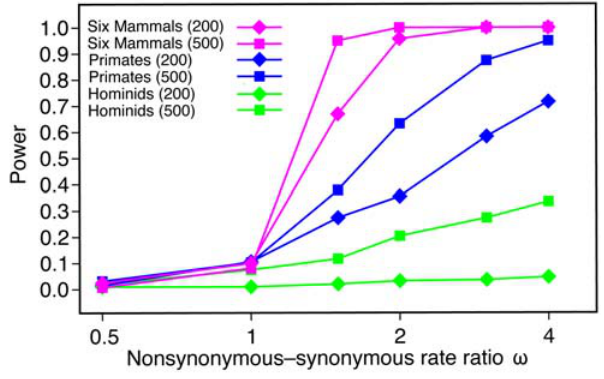
Figure 6. Power of the LRT for selection on any branch of the phylogeny as a function of the nonsynonymous-synonymous rate ratio v . Power is defined as the fraction of tests resulting in nominal P , 0.05. (The effect of controlling for multiple comparisons is shown in Figure S3.) When v # 1, these fractions are estimates of the false positive rate. Each data point is based on 1000 data sets simulated with evolver [84] under the assumption of a constant v among lineages and among sites (model M0). All other parameters (including the transition-transversion ratio k , the codon frequencies, and the branch lengths) were fixed at values estimated from the real data. Results are shown for short (200-codon) and long (500-codon) genes and three sets of species: hominids (human and chimpanzee), primates (human, chimpanzee, and macaque), and all six mammals. Details on the computation of P -values are given in Text S1. Note the logarithmic scale on the x -axis.